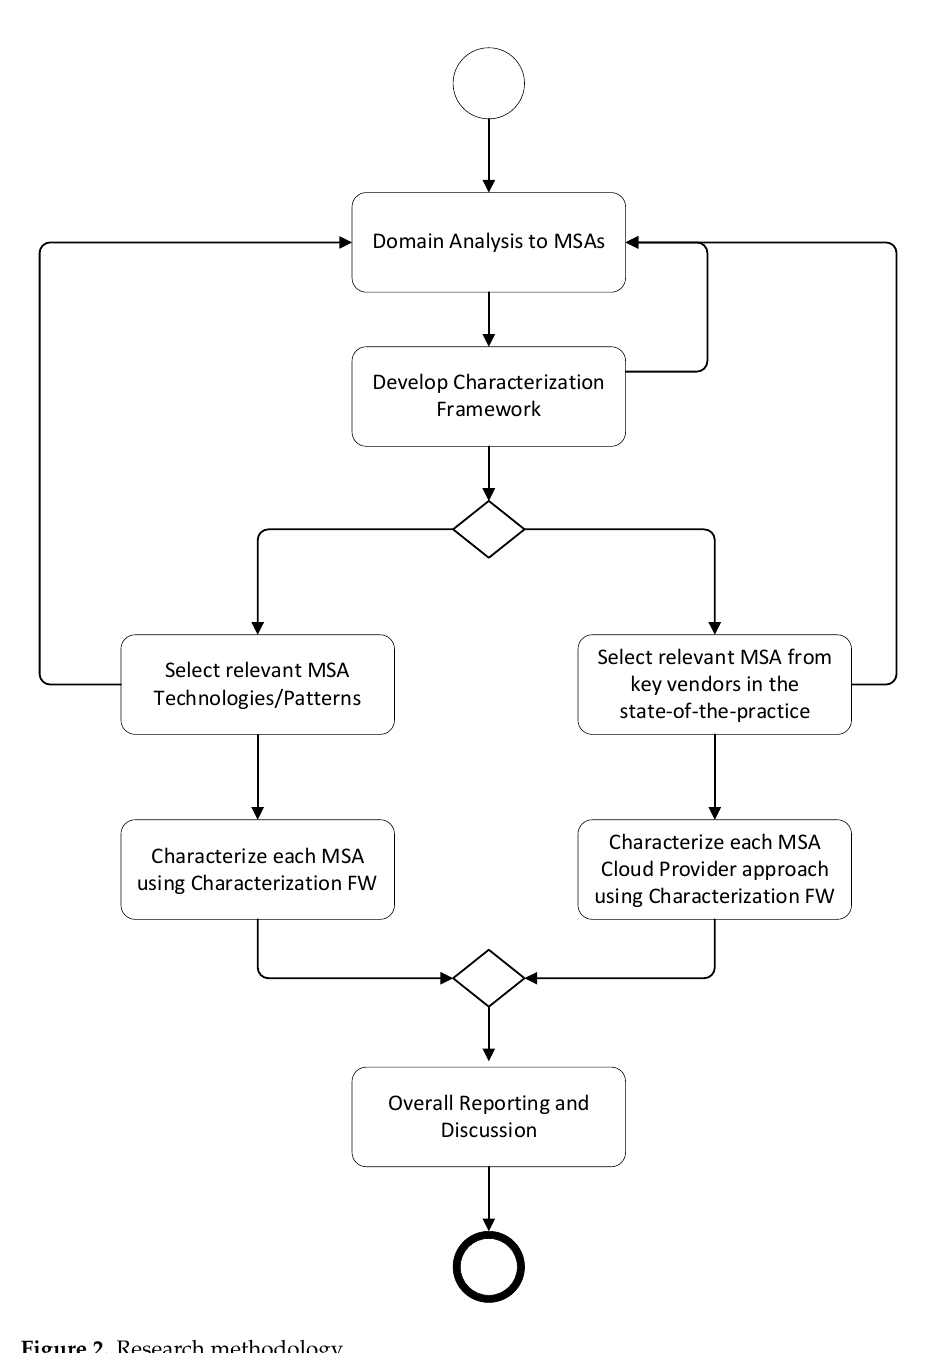
Figure 2. Research Figure 2. Research methodology.